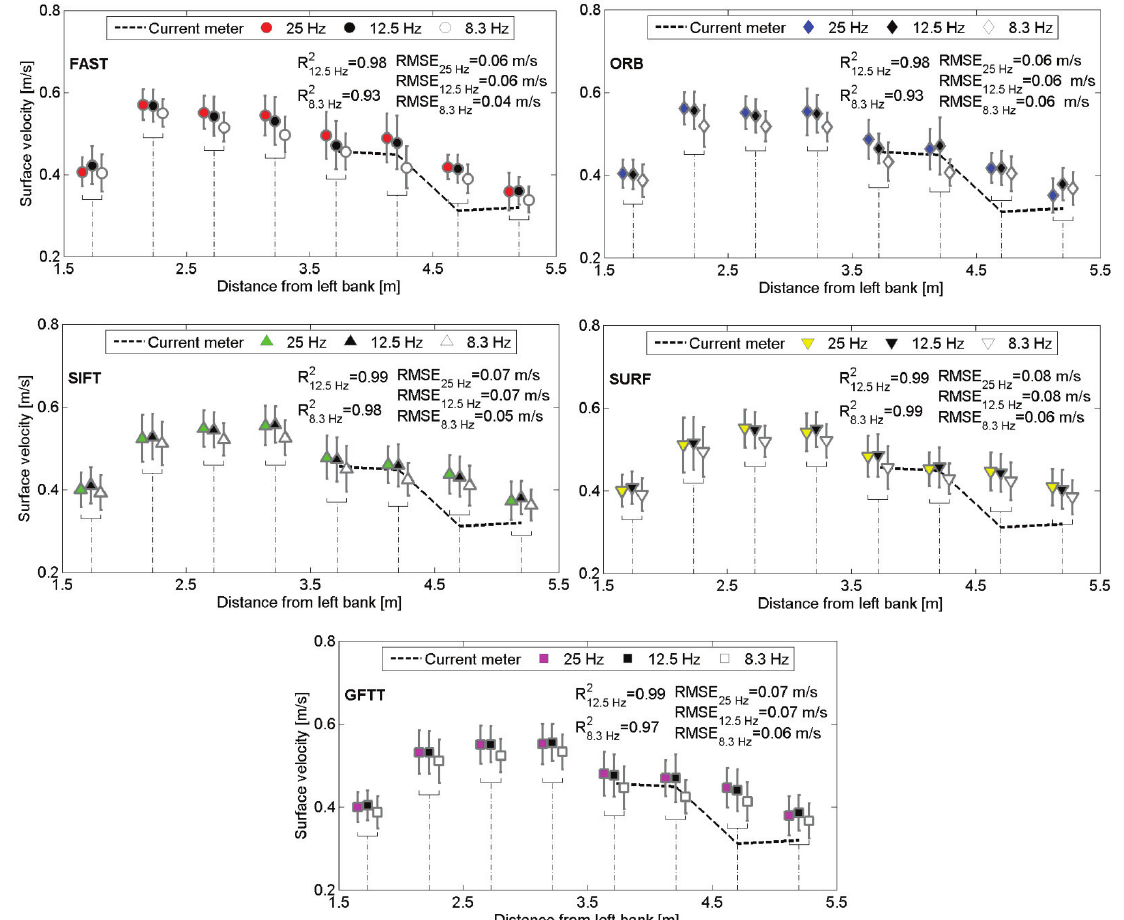
Figure 5. Time-averaged surface flow velocity cross-sectional profiles obtained by processing the 12 image sequences on the Brenta River with OTV. Error bars indicate standard deviations. Black markers pertain to 12.5Hz and white markers to 8.3Hz. The black dashed line illustrates average velocities obtained with the current meter. RMSE values between OTV results and the current meter data are reported. R 2 values computed with respect to the results at 25Hz are showed. OTV data obtained from sequences sampled at different frequencies refer to consistent distances from the left stream bank as indicated with brackets and dash-dotted